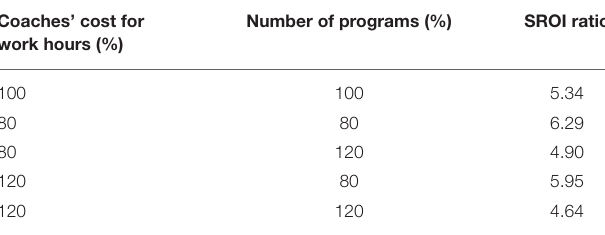
TABLE 2 | Results of sensitivity